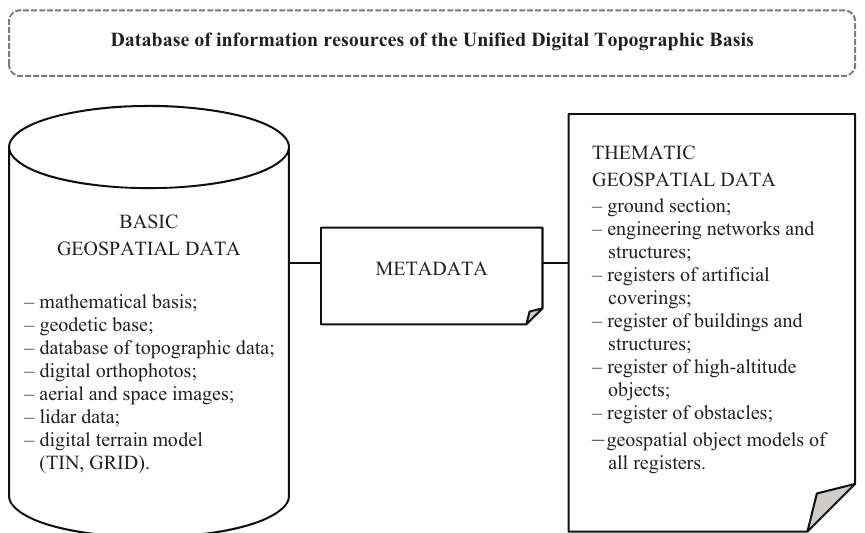
Figure 4. Database schema of the Unified digital topographic airport base